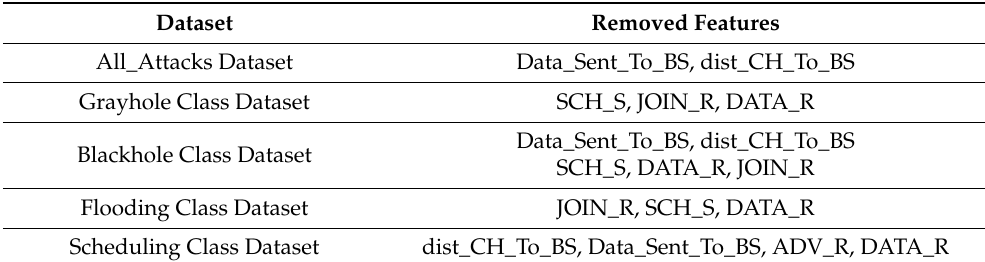
Figure 4. Feature selection results for the extracted balanced dataset. Table 4. The Results of Mutual Information.